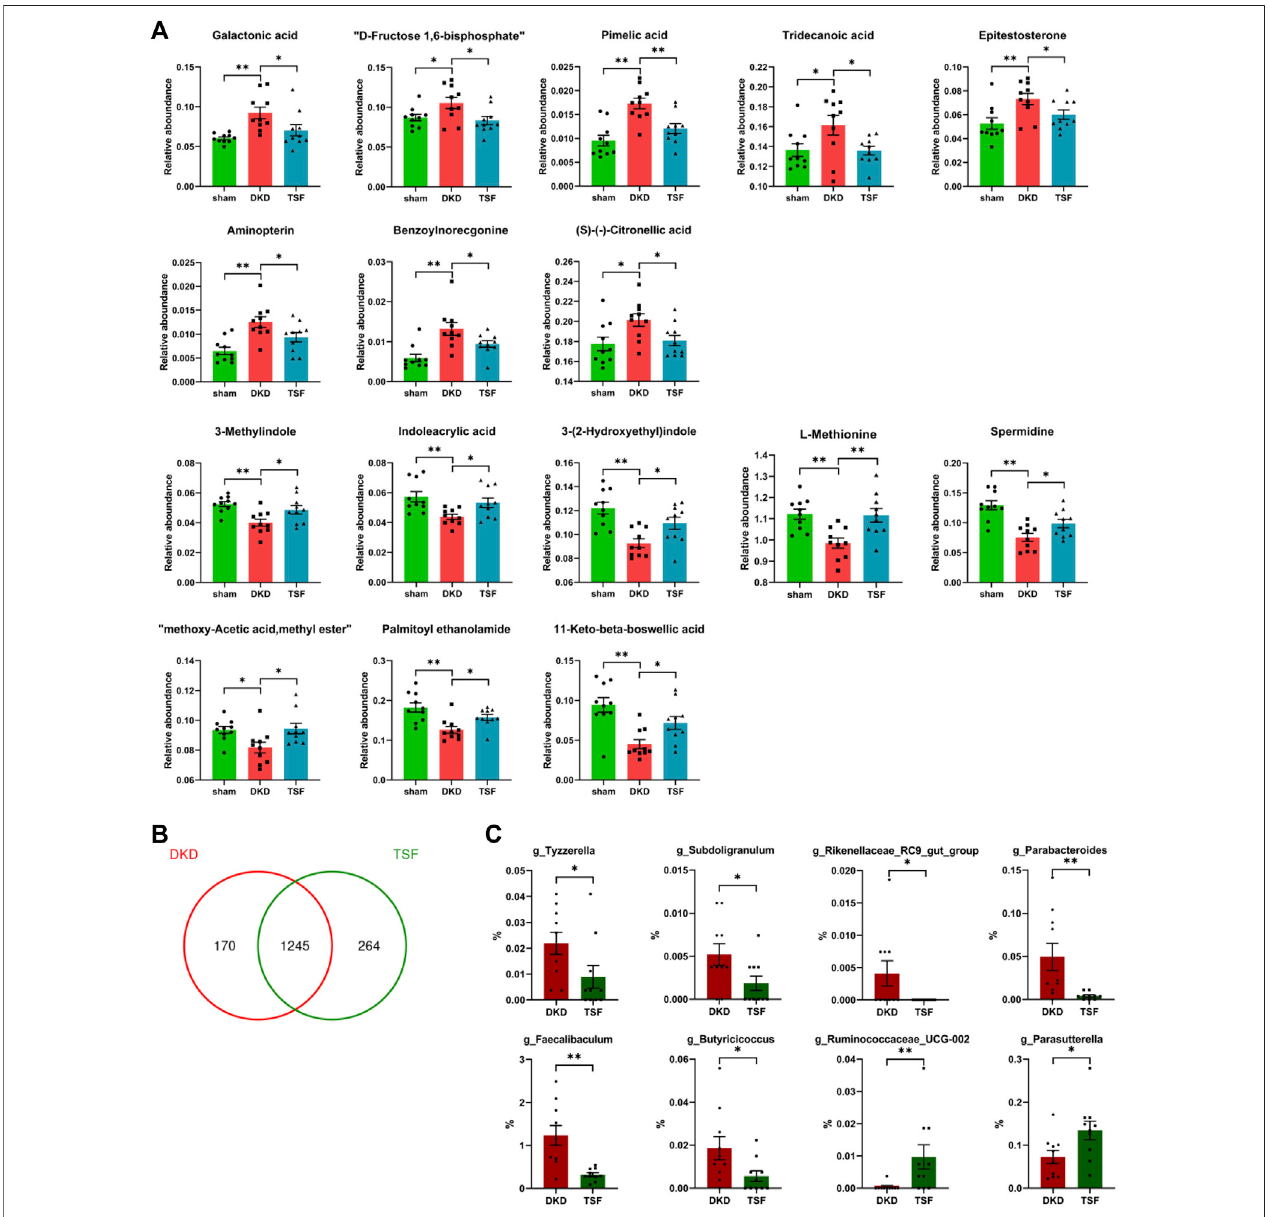
FIGURE 9 | Effects of TSF treatment on serum metabolites and gut microbiota. (A) TSF treatment signi fi cantly improved levels of 16 metabolites in DKD rats as determined using Wilcoxon rank-sum test ( *p < 0.05 , **p < 0.01 ). (B) Effect of TSF treatment on gut microbiota at the OTU level. (C) Relative abundance of genera changes in the TSF group compared with the DKD